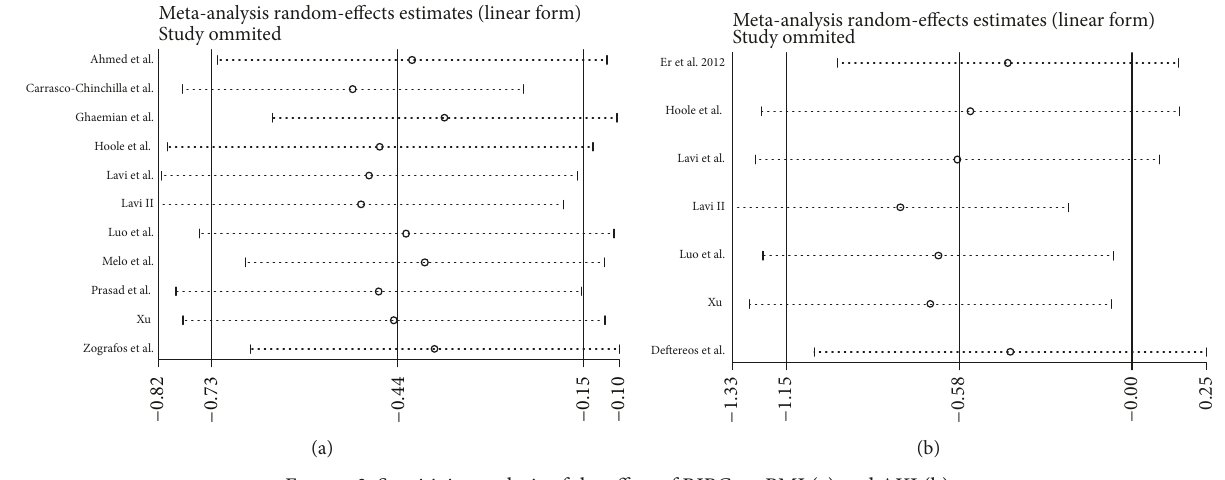
Figure 3: Sensitivity analysis of the effect of RIPC on PMI (a) and AKI (b).